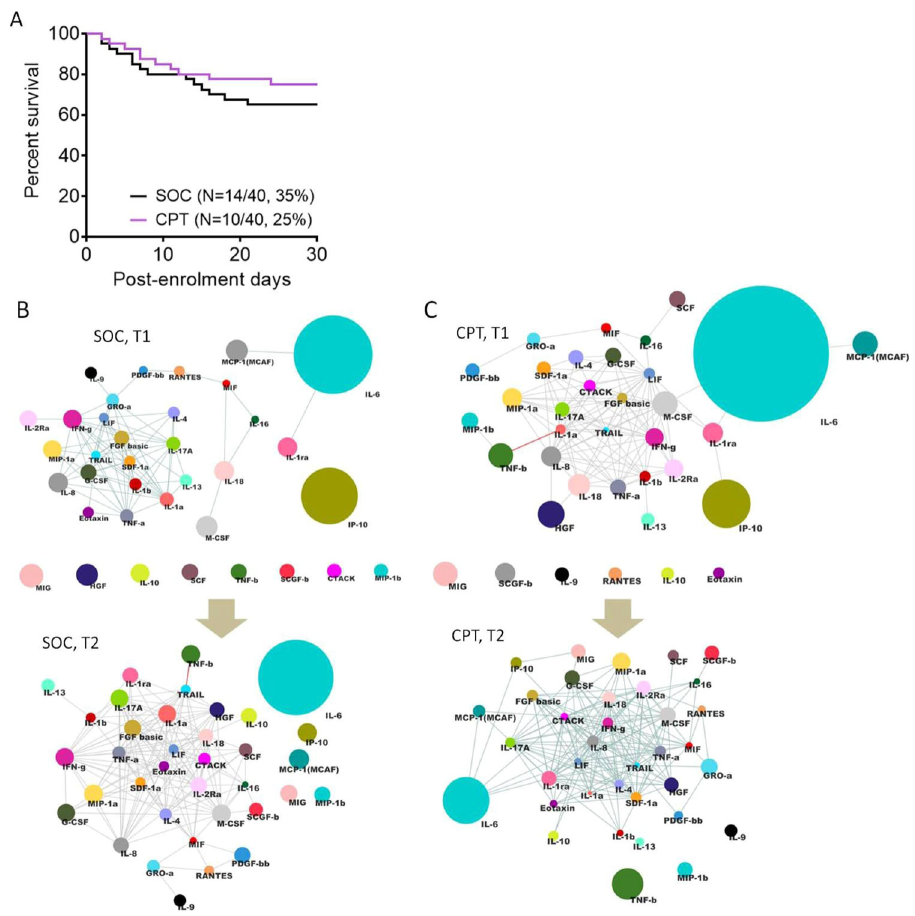
Fig. 4 Primary outcomes compared between two arms of the trial. A Survival of patients in the two arms from the day of enrolment till day 30 post- enrolment are compared in a Kaplan – Meier curve, for all age groups. Surviving patients were censored on day 30 post-enrolment. For all outcomes Mantel- Cox log-rank test was performed and corresponding P -values are only shown for statistically signi fi cant differences. Panels B and C describe the correlation network for 36 cytokines measured in plasma of severe COVID-19 patients, from both SOC and CPT group at T1 and T2 timepoints, respectively. The diameter of the nodes represents extent of enriched abundance compared against a median value derived from patients with mild disease. Edges are shown only for Spearman correlation value of 0.7 and